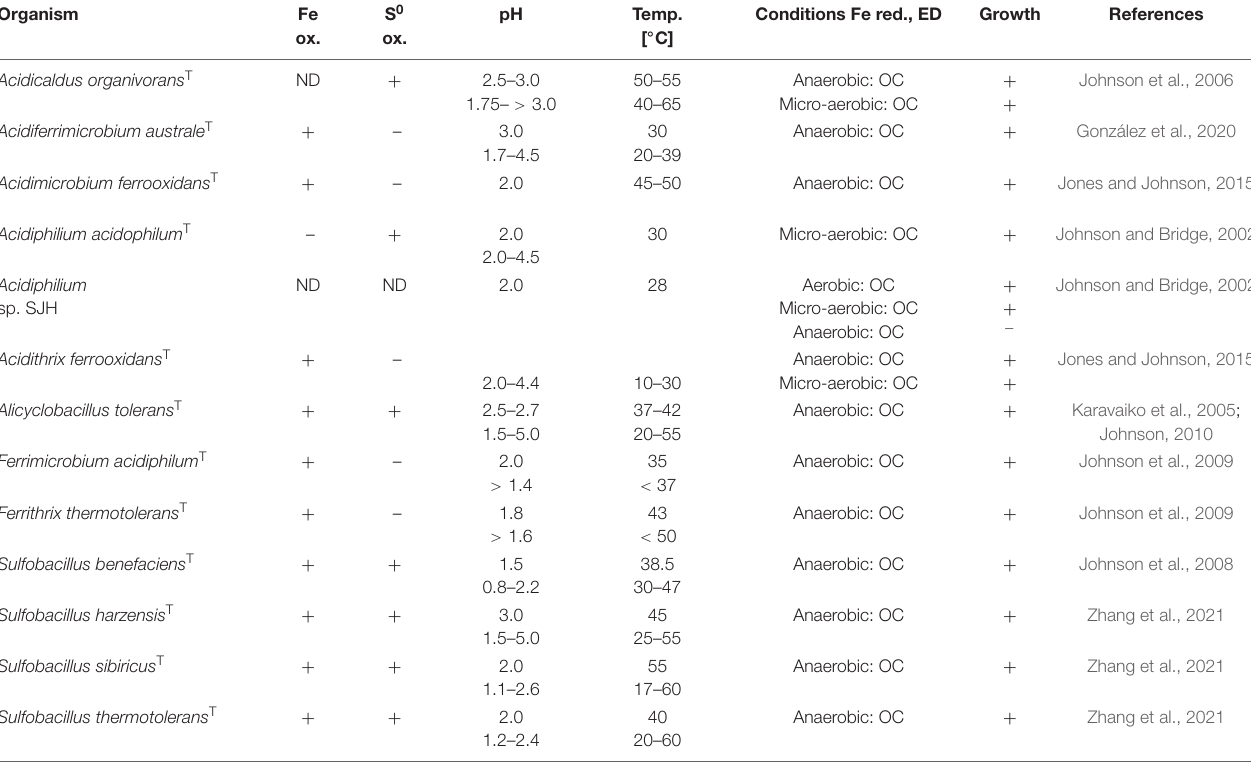
TABLE 5 | Ferric iron-reducing extreme acidophilic heterotrophic bacteria. Organism Fe